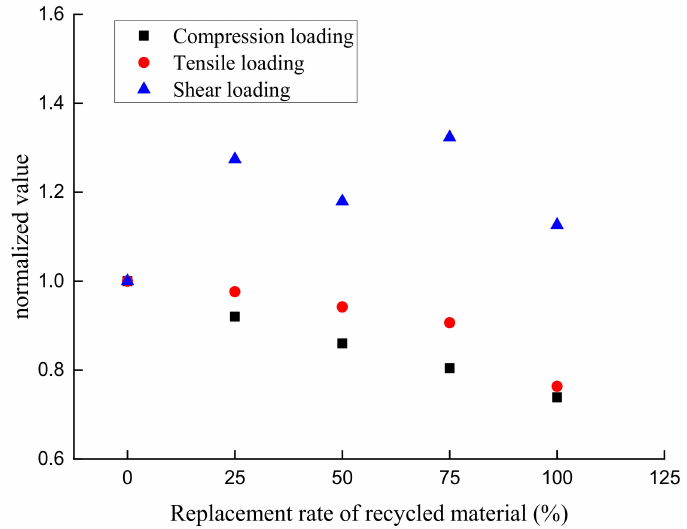
Figure 6. Correlation between the substitution ratio and normalized